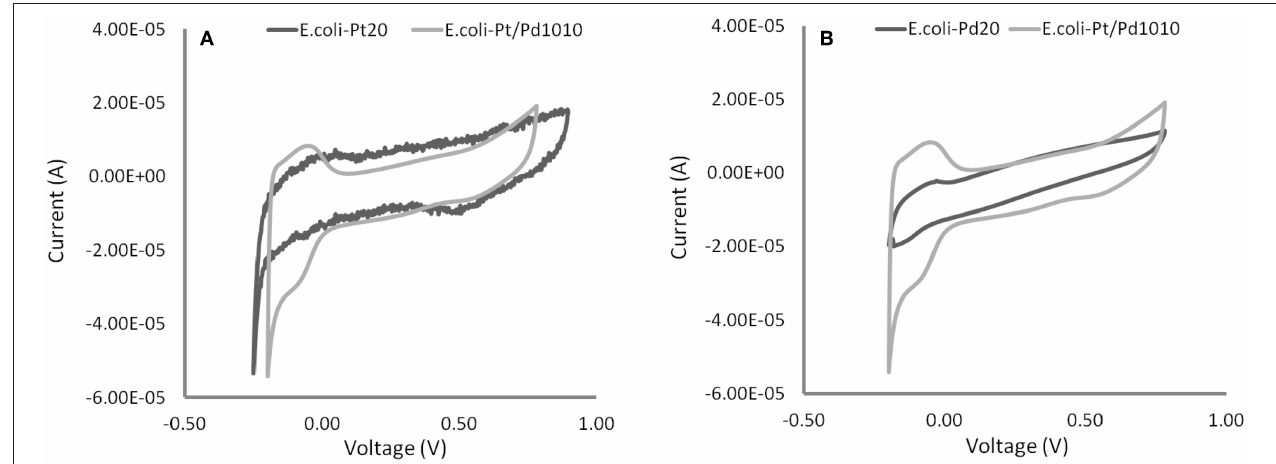
FIGURE 6 | Electrochemical tests (cyclic voltammograms) of the bimetallic catalyst compared against 20 wt% Bio-Pd in (A) and 20 wt% Bio-Pt in (B) in 0.1M HNO 3 at 25 ◦ C and in N 2 -saturated solutions with a scan rate of 100 mV/s. Distinct peaks are apparent for E. coli -Pt/Pd (10%:10%) relative to both E. coli -Pd(20%) and E. coli -Pt (20%).